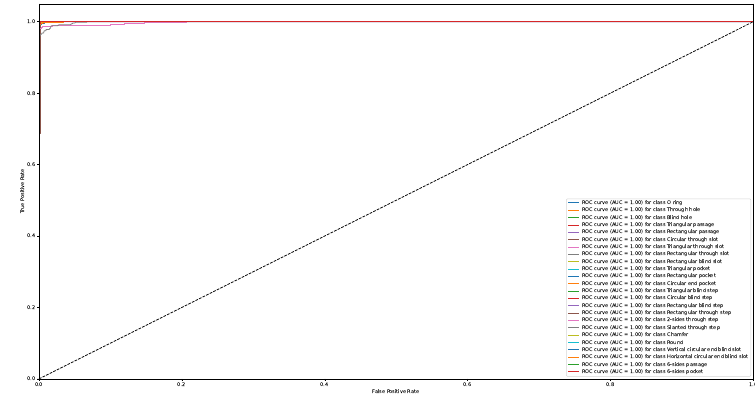
Figure A11. ROC curve for MsvNetLite.